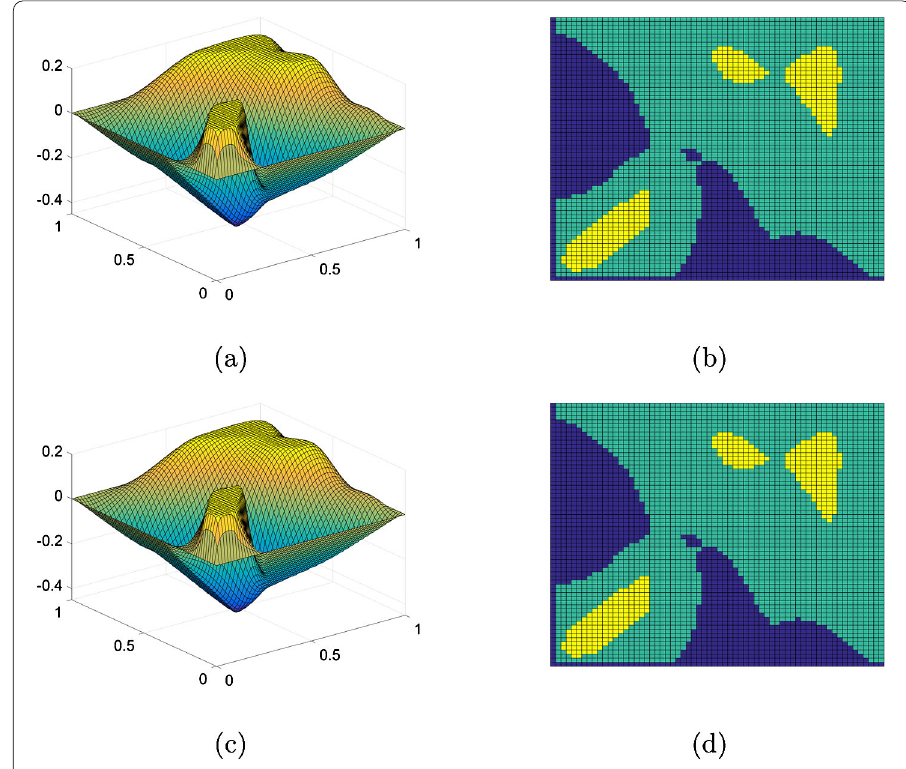
Figure 7 The numerical solutions and the contact sets for the elastic-plastic torsion problem at the 64 × 64 resolution. (a) - (b) by the PDL1P and (c) - (d) by the obstacle SOR.